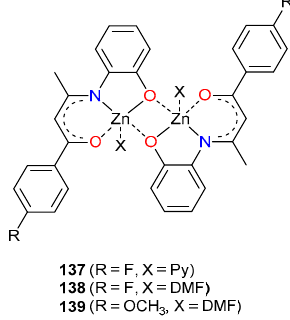
ff -base zinc complexes 137–139 Figure 24. [ONO]-type Schiff-base zinc complexes 137–139 [81]. Figure 24. [ONO]-type Schi Figure 24. [ONO]-type Schiff-base zinc complexes 137–139 [81].